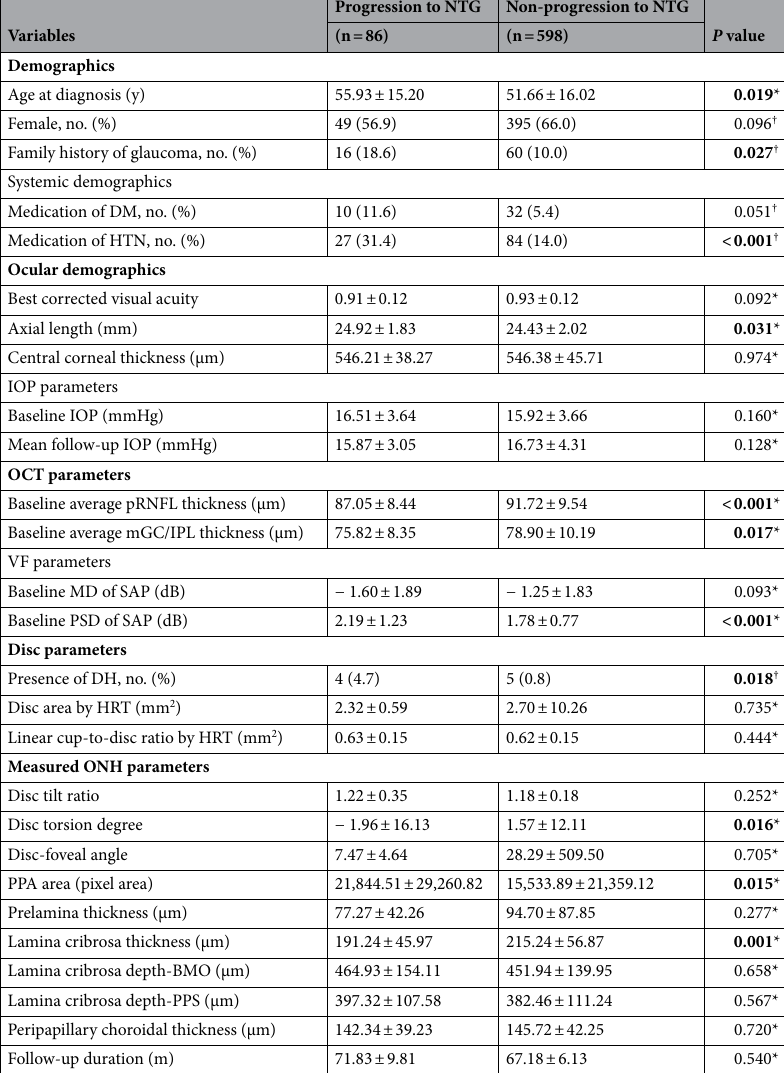
layer; mGC-IPL, macular ganglion cell-inner plexiform layer; IOP, intraocular pressure; VF, visual field; MD, mean deviation; PSD, pattern standard deviation; dB, decibel; MD, mean deviation; SAP, standard automated perimetry; DH, disc hemorrhage; HRT, Heidelberg retinal tomograph; ONH, optic nerve head; PPA, peripapillary atrophy; BMO, Bruch’s membrane opening; PPS, peripapillary sclera. Data are mean ± standard deviation unless otherwise indicated. *Student’s t test. † Chi-square test. Data are mean ± standard deviation unless otherwise indicated. Factors with statistical significance are shown in